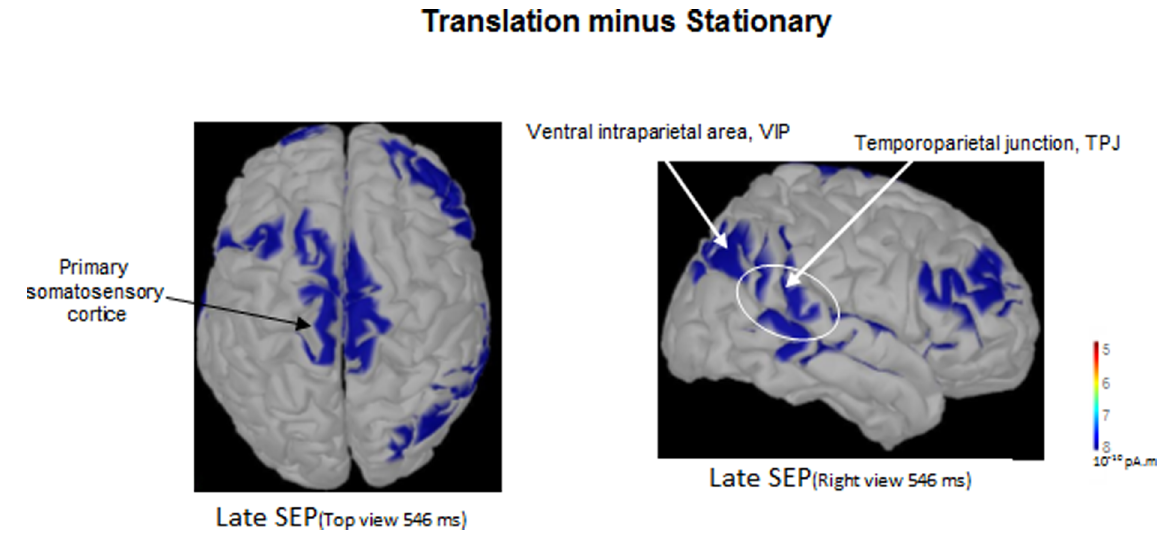
Figure 4. Results of source reconstruction from the grand average EEG data of the 6 participants (Low Resolution Electromagnetic Tomography, sLORETA) displayed on the used source space (Montreal warp brain aligned to the co-ordinate system of Talairach and Tournaux). sLORETA images depicted the estimated current density strengh corresponding to the effect of translation relative to baseline (Translation minus Stationary) for the Late SEP. The scale of the maps was chosen to maximize identification of the sources and were given a marked threshold to only show source activity that was 18% upper of minimal activation. Note the clearly distinguishable activation above the primary somatosensory cortice (top view) and the right posterior parietal cortex (e.g., VIP) and the Temporoparietal region.